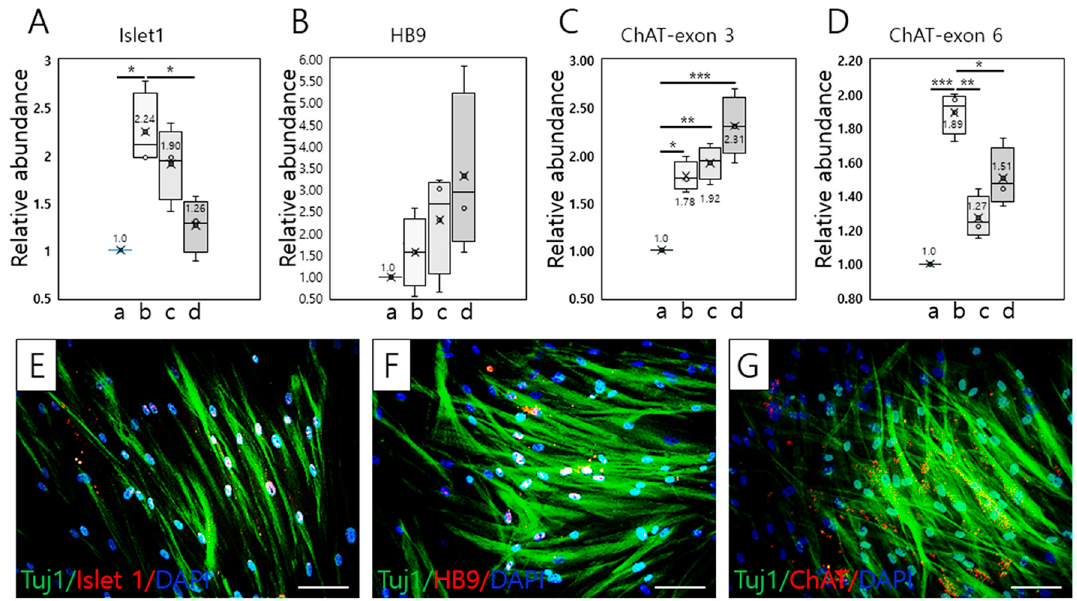
Figure 2. Schematic of the derivation of MN-like cells from T-MSCs. ( A – D ) Time-course RT–qPCR analysis of the expression of Islet 1, HB9, and ChAT during differentiation of T-MSC-MNCs ( n = 3). Data are presented as the mean ± SEM of at least three experiments. a = T-MSC; b = 2 weeks differentiation; c = 3 weeks differentiation; d = 4 weeks differentiation. The statistical analysis was performed using one-way ANOVA (* p < 0.05; ** p < 0.01; ** p < 0.001). ( E – G ) Double immunostaining analysis for detection of MN markers, Islet 1 ( E ), HB9 ( F ), and ChAT ( G ) plus Tuj1 after 2 weeks of MN di ff erentiation. DAPI staining (blue), immunostaining for neuron-specific β -tubulin class III (Tuj1; green), Islet 1 (red), homeobox HB9 (HB9; red). White indicates the merged images for DAPI, Tuj1, and Islet 1 or HB9; yellow indicates the merged images for Tuj1 and ChAT. Scale bars = 100 µ